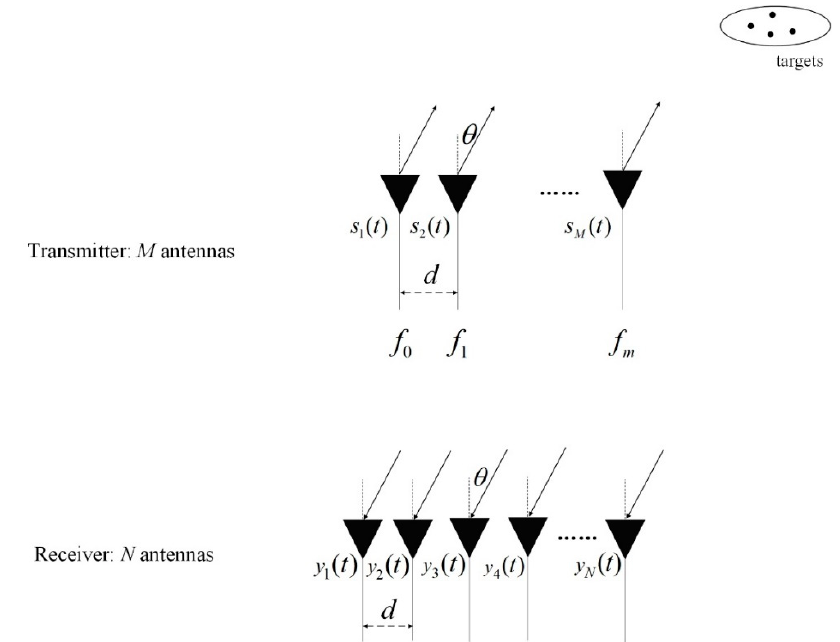
Figure 1. Monostatic FDA-MIMO radar.